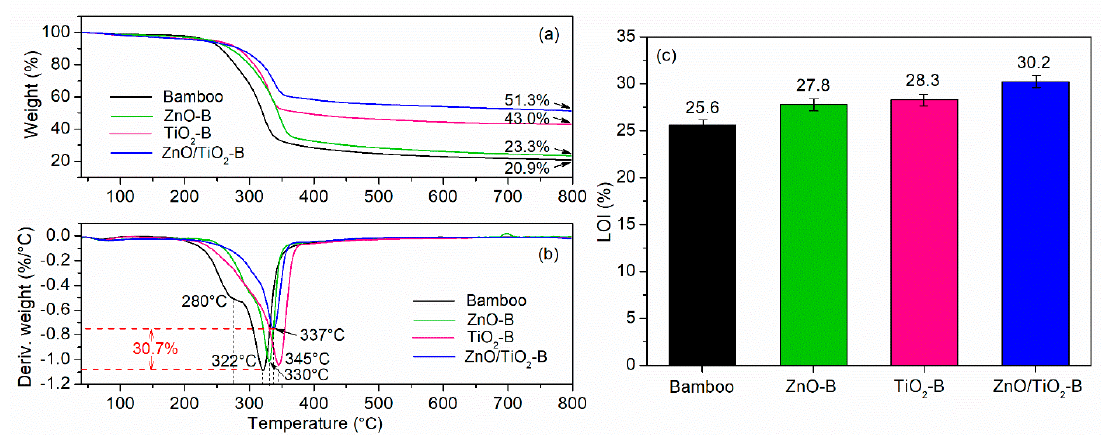
Figure 9. ( a ) TG curves; ( b ) DTA curves; and ( c ) LOIs of pristine bamboo, ZnO-B, TiO 2 -B and ZnO/TiO 2 -B.